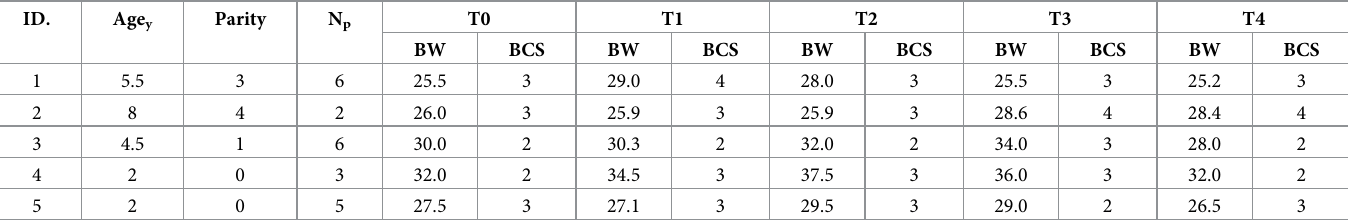
Table 2. Age, parity, litter size body weight and body condition score of the dams enrolled in the study. ID.